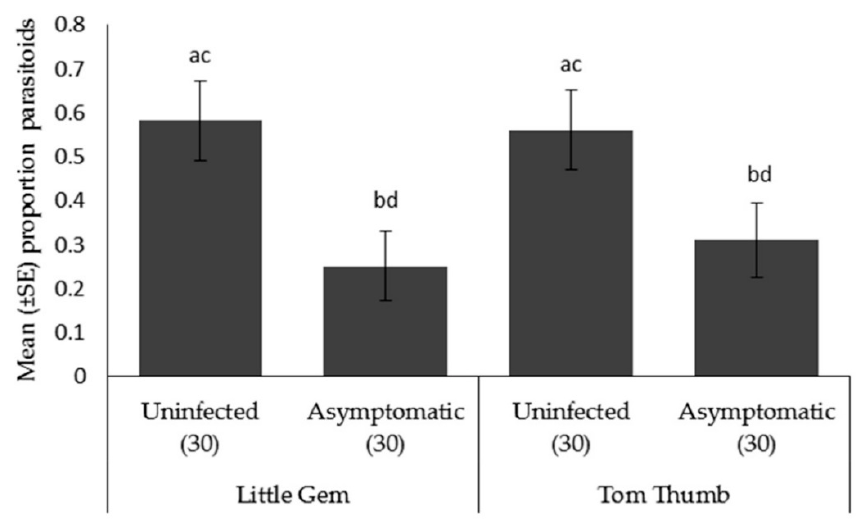
Figure 4. Mean ± SE proportion of parasitoids Aphidius colemani orientating in an olfactometer trial